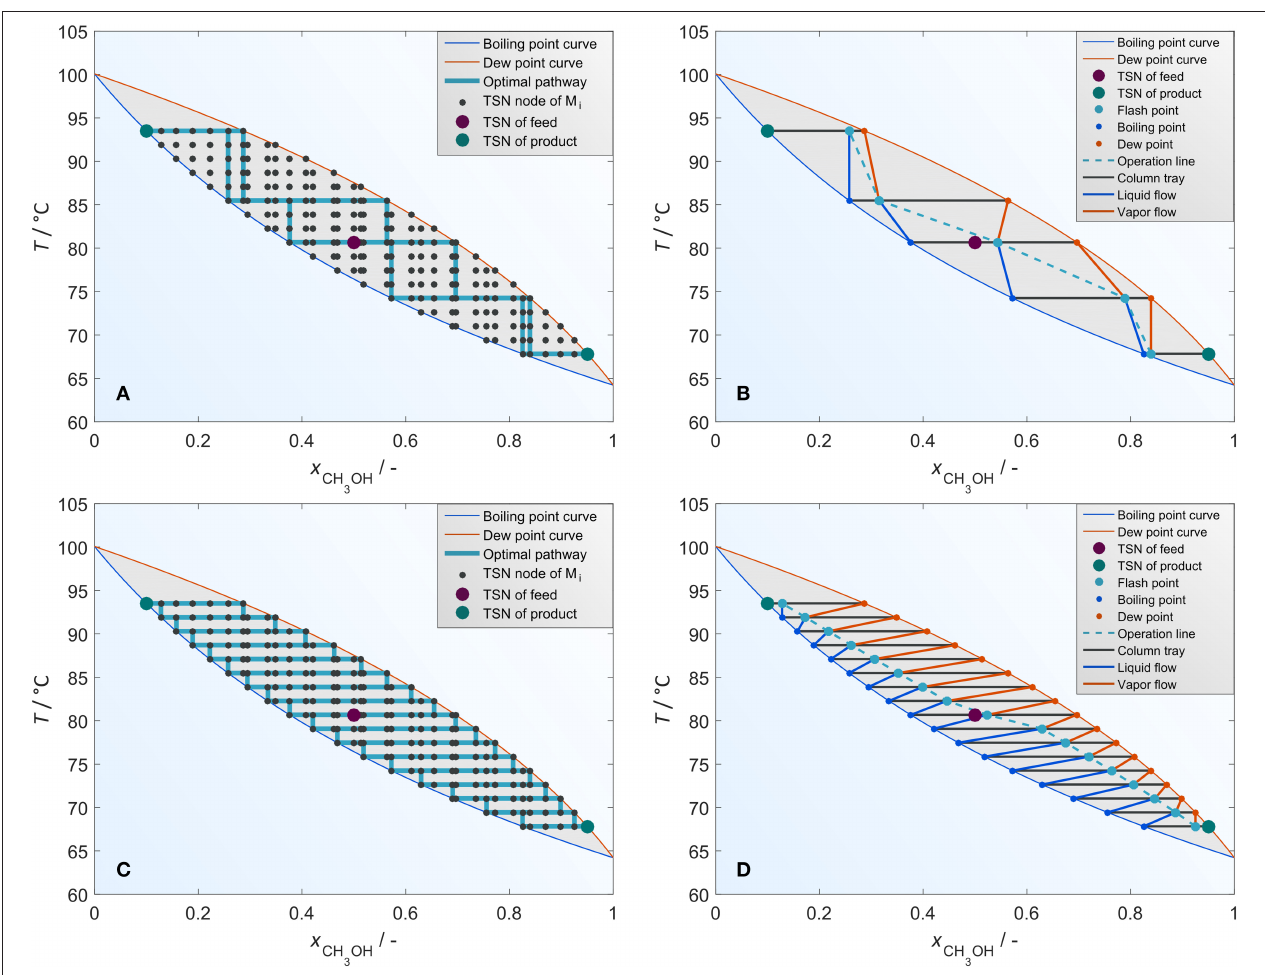
FIGURE 5 | Optimal pathway within the thermodynamic state space for the two objective functions (Equations 11, 12; left-hand sides), and corresponding operation line for a temperature discretization of 17 (right-hand sides); minimization of number of trays (A,B) , and total energy minimization (C,D)